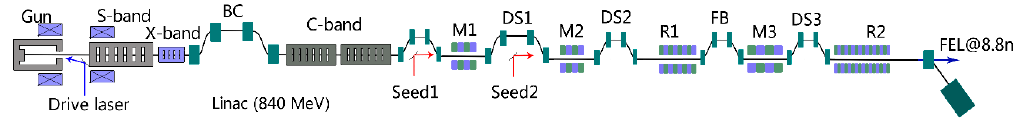
Figure 1. Schematic layout of the Shanghai soft X-ray Free-Electron Laser Test Facility (SXFEL-TF), including a photo-cathode injector, a main linac, and an undulator system (BC: bunch compressor, M: modulator, DS: dispersion section, R: radiator, FB: fresh bunch).